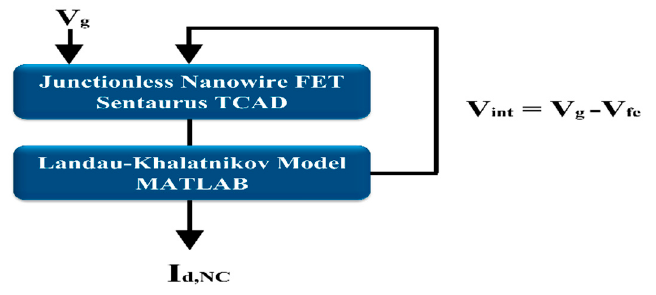
Figure 2. Simulation flow chart of NC-JL-NWFET using Sentaurus TCAD and MATLAB tools. Table 1. Device Design Parameters for NC-JL-NWFET. Parameters Value Doping concentration (N) in channel/source/drain 10 19 /cm 3 Channel length 20 nm Channel radius 5 nm Ferroelectric thickness (T fe ) 4 nm Ferroelectric (Al: HfO 2 ) remnant polarization (P r ) 16 µC/cm 2 Ferroelectric (Al: HfO 2 ) coercive voltage (E c ) 1.51 MV/cm Equivalent oxide thickness (T ox ) 1 nm